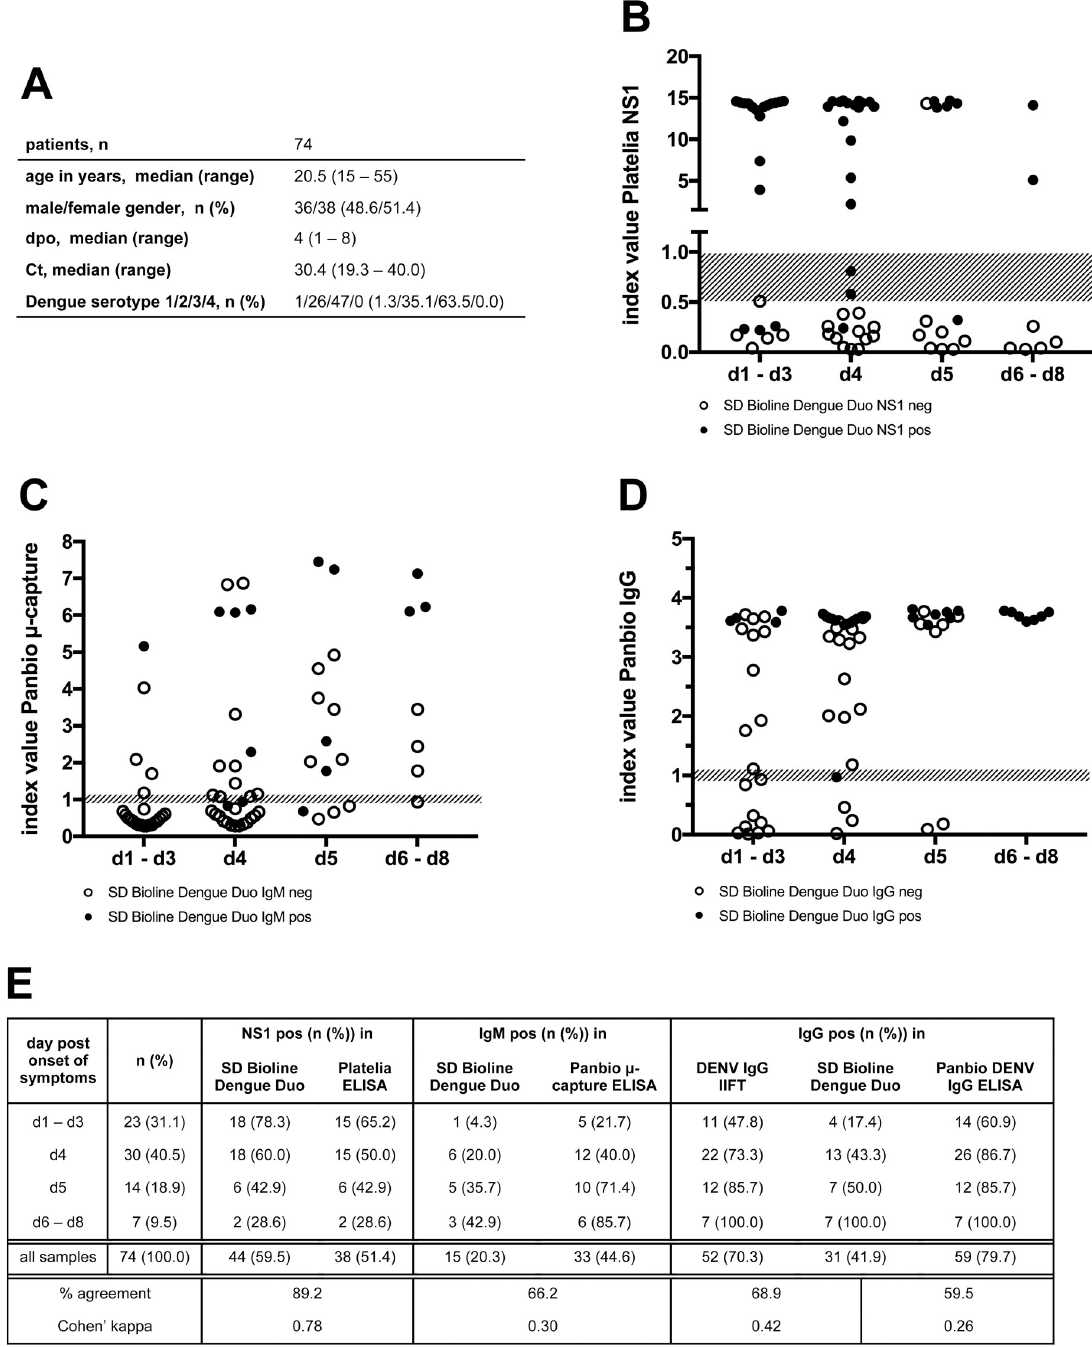
Fig 3. Comparison of SD Bioline Dengue Duo test results with ELISA results and DENV IgG IIFT. A subset of 74 acute phase serum samples (A) was analyzed with the Platelia NS1 Antigen ELISA (B) , the Panbio DENV μ -capture ELISA (C) and the Panbio DENV IgG ELISA (D) . Open/filled circles represent negative/positive results obtained with the corresponding SD Bioline Dengue Duo tests. Shaded areas represent index values rated as equivocal according to the respective manufacturer’s recommendations. (E) Tabular summary of results and statistical